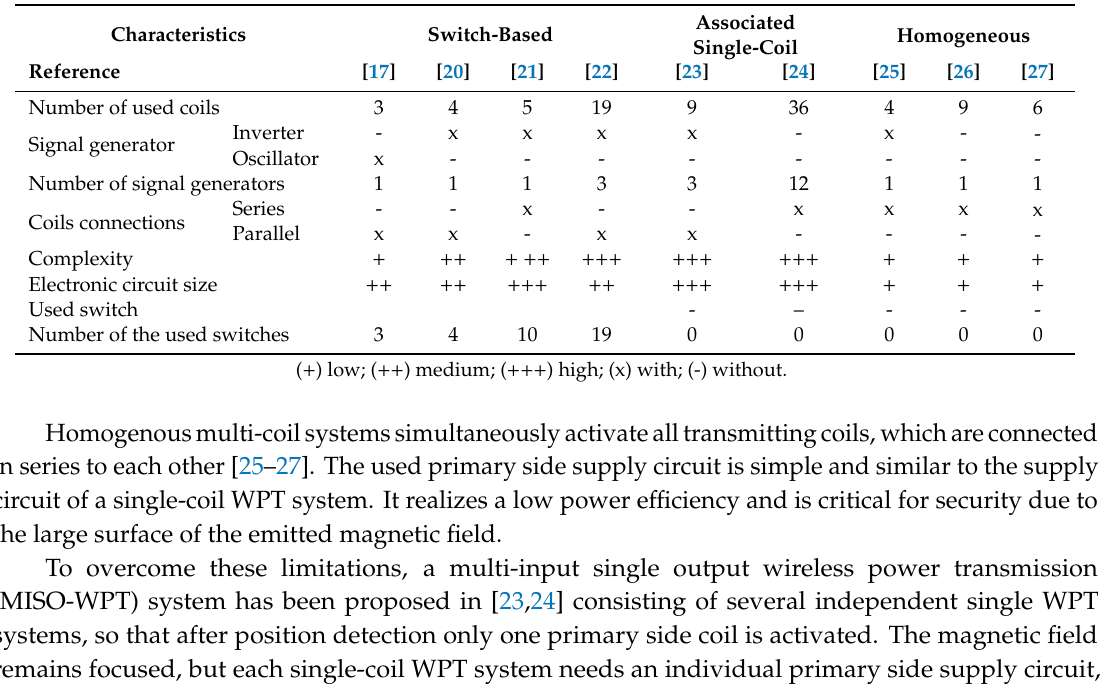
Table 1. Selected phase of the art solutions for multi-coil